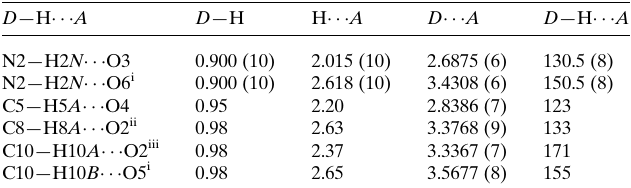
Table 1 Hydrogen-bond geometry (A˚ , (cid:2) ).